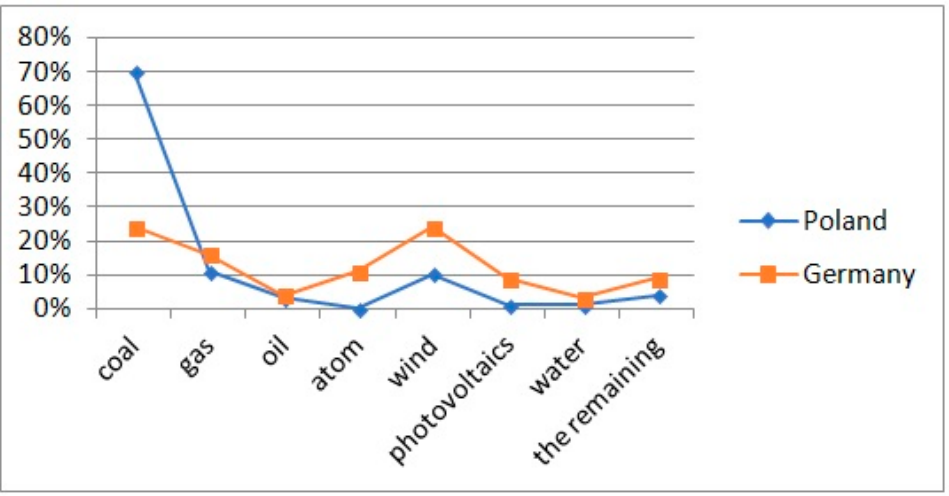
Figure 25. Structure of the energy mix of Poland and Germany regarding electricity production (%) [72].